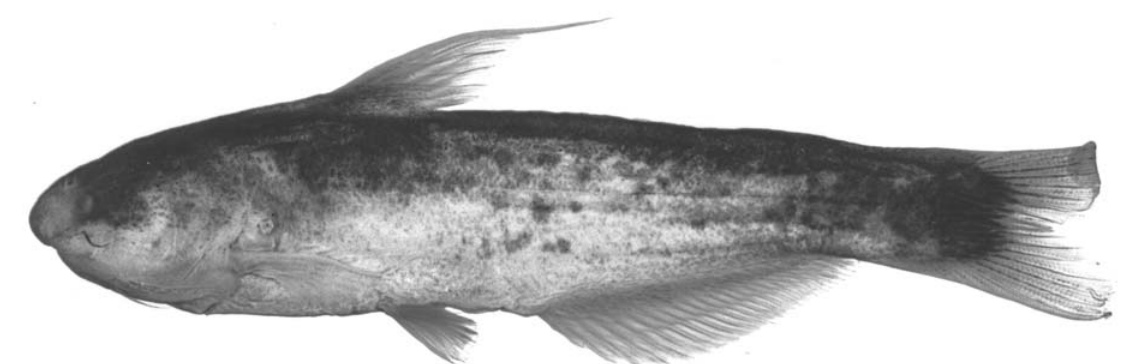
Fig. 43. Cetopsis starnesi , new species, holotype, mature male, USNM 314309, 77 mm SL; Bolivia, Tarija, Argentinean-Bolivian border, río Bermejo, 4-5 km south of Pueblo Salado, approximately 30 air km south of Bermejo (22°27’S,